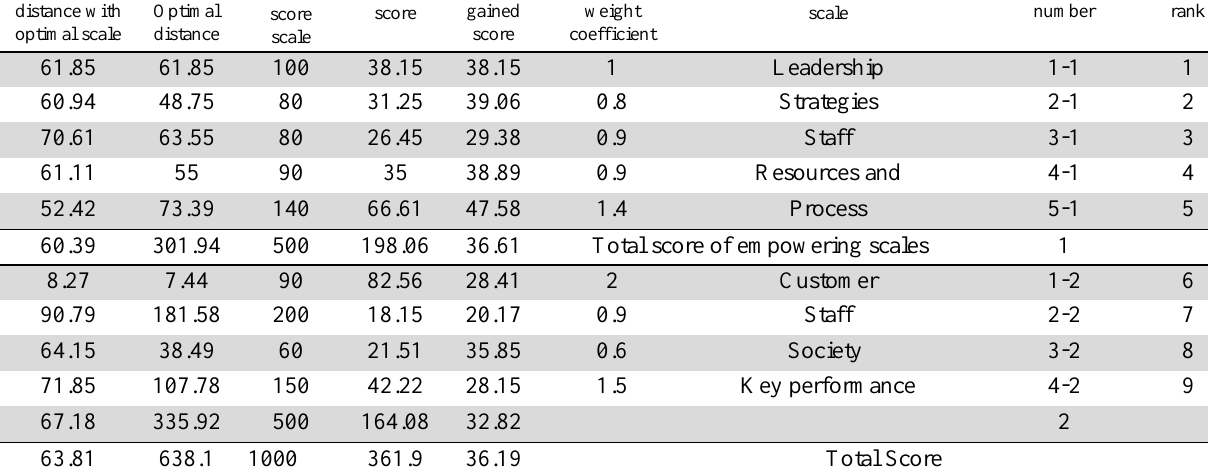
The summary of the results of the implementation of EFQM method distance with Optimal optimal scale